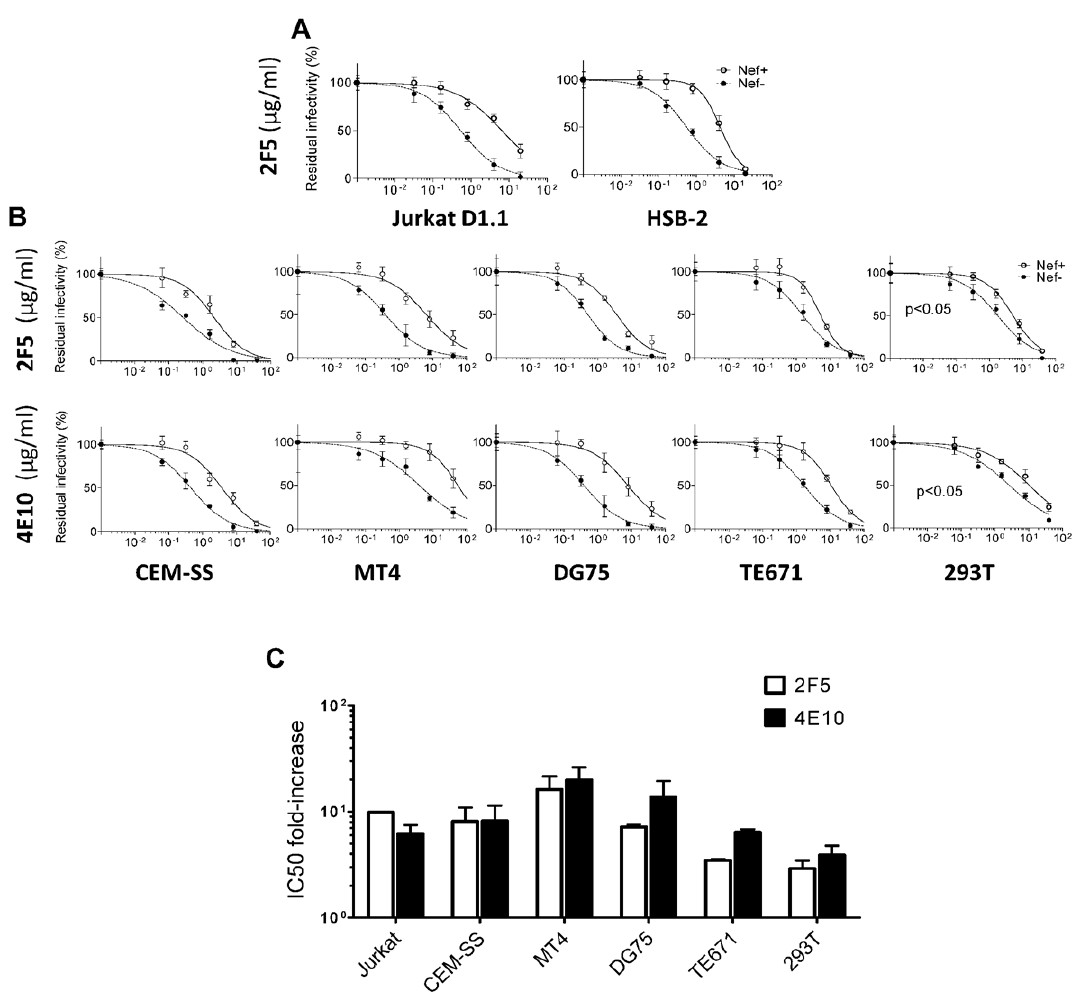
Figure 5. The effect of Nef on neutralization does not depend on the presence of CD4 in producer cells and is observed with HIV-1 derived from various cell lines. A, neutralization of wild-type and Nef-defective HIV-1 NL4-3 produced in two CD4-negative T lymphoid cell lines. B, Neutralization of wild type andNef-defective NL4-3 pseudotypedwith Env JRFL produced in theindicated cell lines. C, Fold-change of IC50 values for 4E10 and 2F5, derived from the fitted sigmoidal curves shown in B, caused by Nef. Neutralization was performed three times independently. Shown are the mean valuesandSD.Thesignificanceof thedifferences of IC50 values wereassessedby2-tailMann-Whitneytest,whichretrieved forall samples p , 0.05.